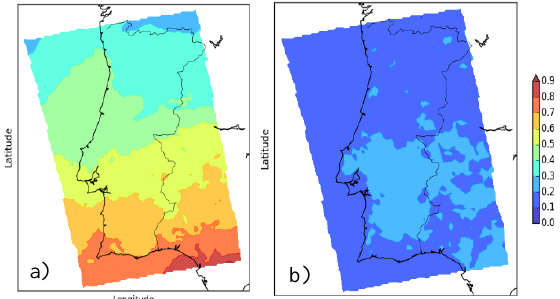
Figure 7. Monthly mean Aerosol Optical Depth (AOD) for May 2011. a) Spatial distribution obtained with CAMx and b) Spatial Figure 5. PM mass (g.m -2 ) are shown for 14 th May 2011 at 14 UTC.